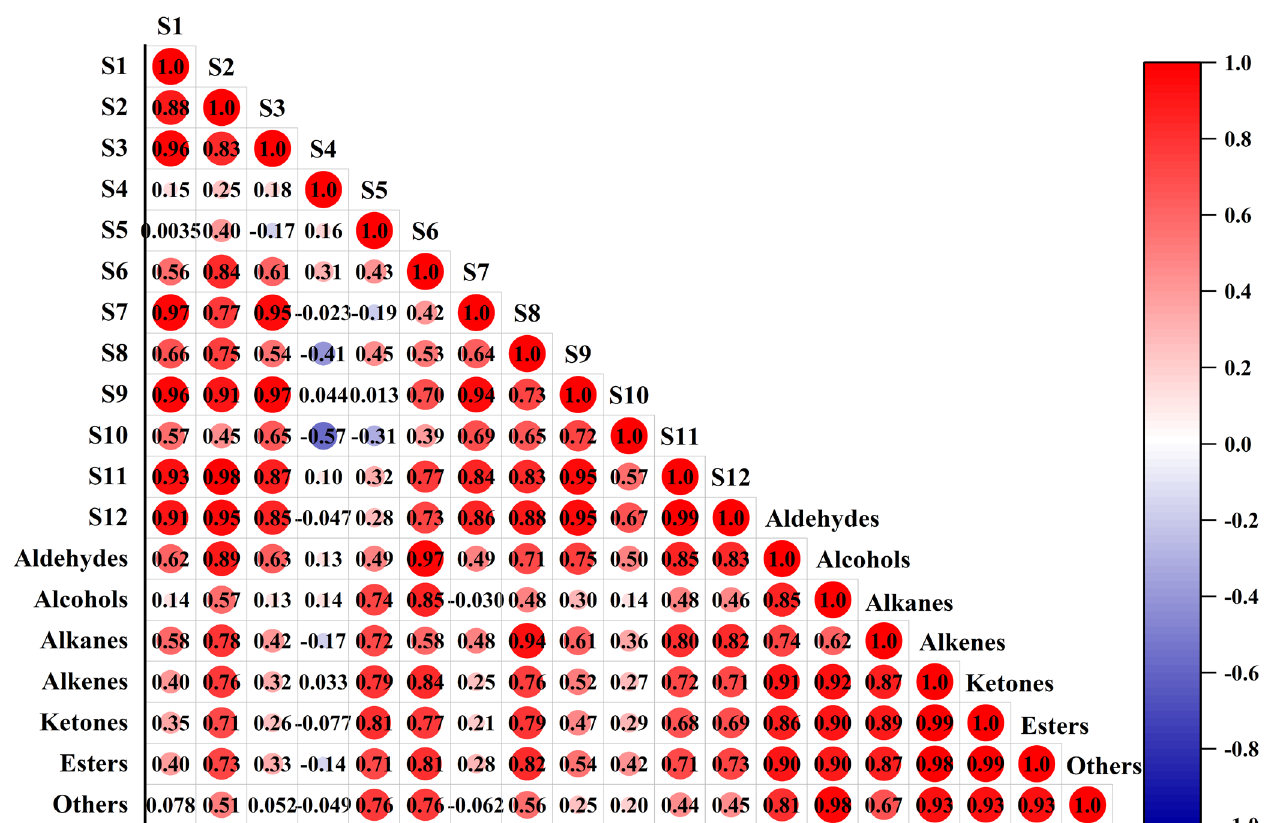
Figure 7. Correlation analysis between sensors and volatile compounds.